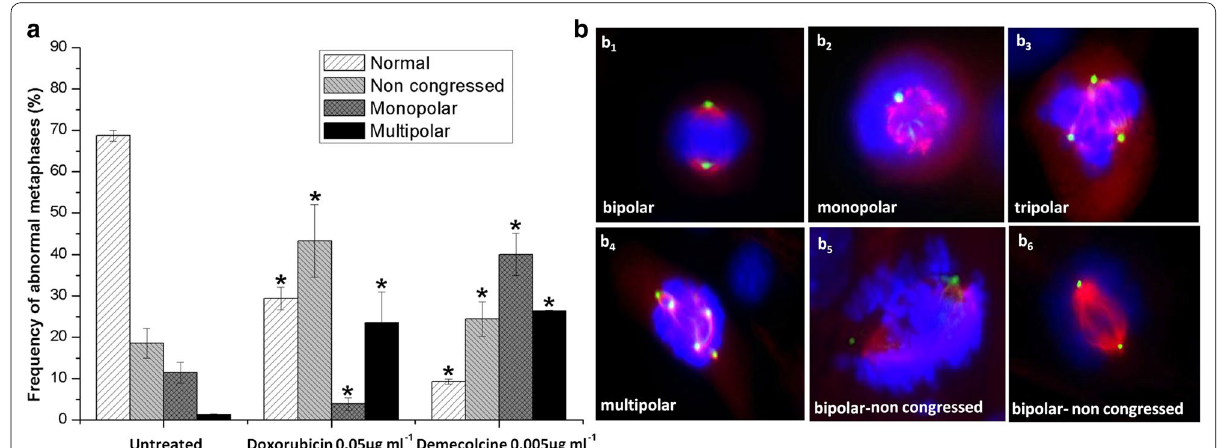
DOX doxorubicin, DEM demecolcine was used as positive control, M.I. Mitotic Index, SE standard error